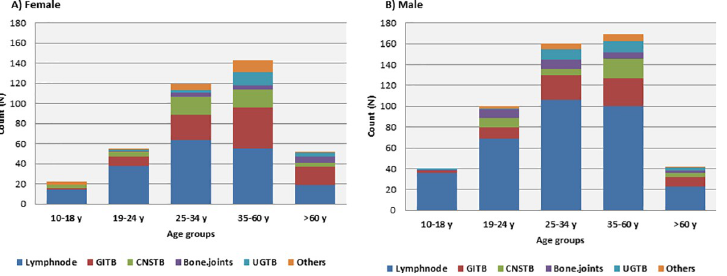
Fig 3. Gender, site of infection and distribution of age groups. Gastrointestinal TB (GITB), Central nervous System TB (CNSTB) and Urogenital TB (UGTB) were abbreviated as illustrated. All cases of pericardial, skin, soft tissue, blood and oral TB were represented as